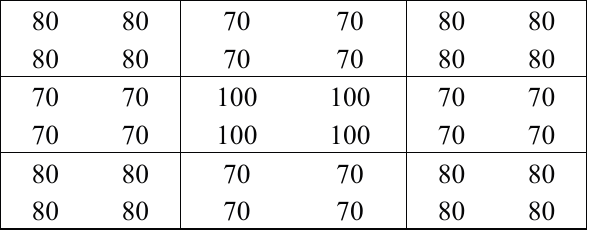
Table 5. Force map of arbitral distribution setting under 2.8 kg loading.